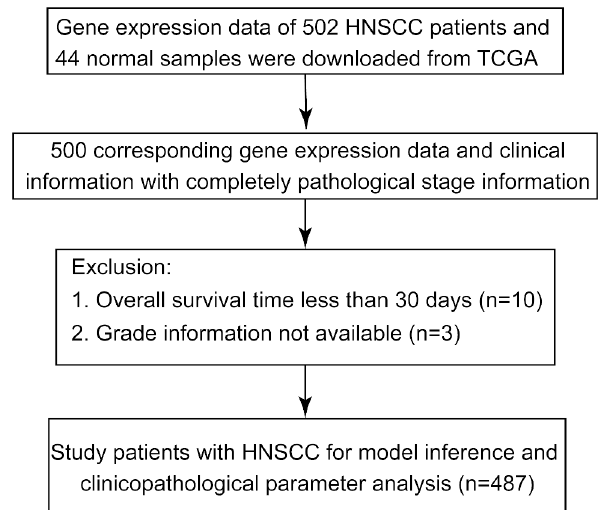
Fig. 1 The patient flow